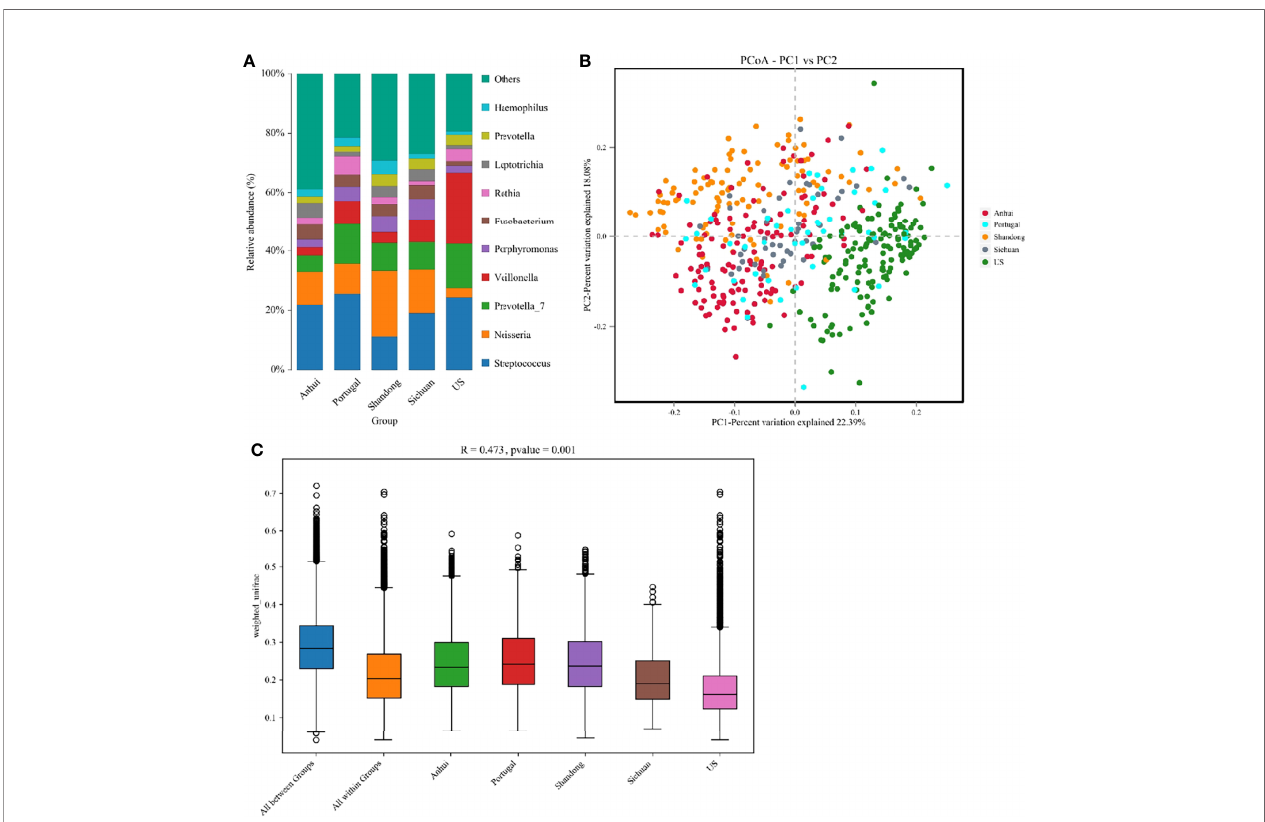
FIGURE 1 | (A) The structure analysis of the microbial community. The composition statistics were calculated for each sample at the phylum, order, family, genus, and species levels. This fi gure showed bar graphs of microbial abundance at the genus level for the fi ve studies. (B) The PCoA of all samples from the fi ve studies based on Weighted-Unifrac distances. X-axis and y-axis represented two eigenvalues that maximized the differences between samples, respectively. (C) R and p values for beta diversity based on Weighted-Unifrac distances calculated using the Anosim analysis (analysis of Similarities). The closer the R value was to 1, the greater the differences between groups were than the differences within groups; the smaller the R value, the less signi fi cant the differences between the groups. p < 0.05 showed high reliability of the test. The box above “ All between Groups ” indicated the Weighted-Unifrac distance data of the samples among all groups, while the box above “ All within Groups ” indicated the Weighted-Unifrac distance data of the samples within all groups. The box below represented the Weighted-Unifrac distance data of samples within different groups.